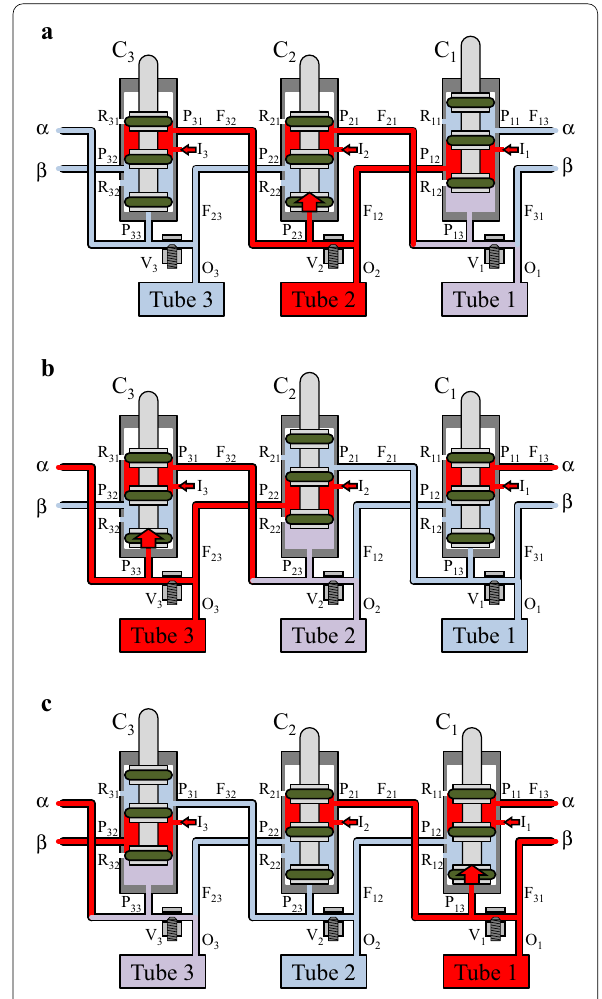
Fig. 6 Principle of self-excited motion generation. a – c show the states with plungers in C 1 , C 2 , and C 3 extended, respectively